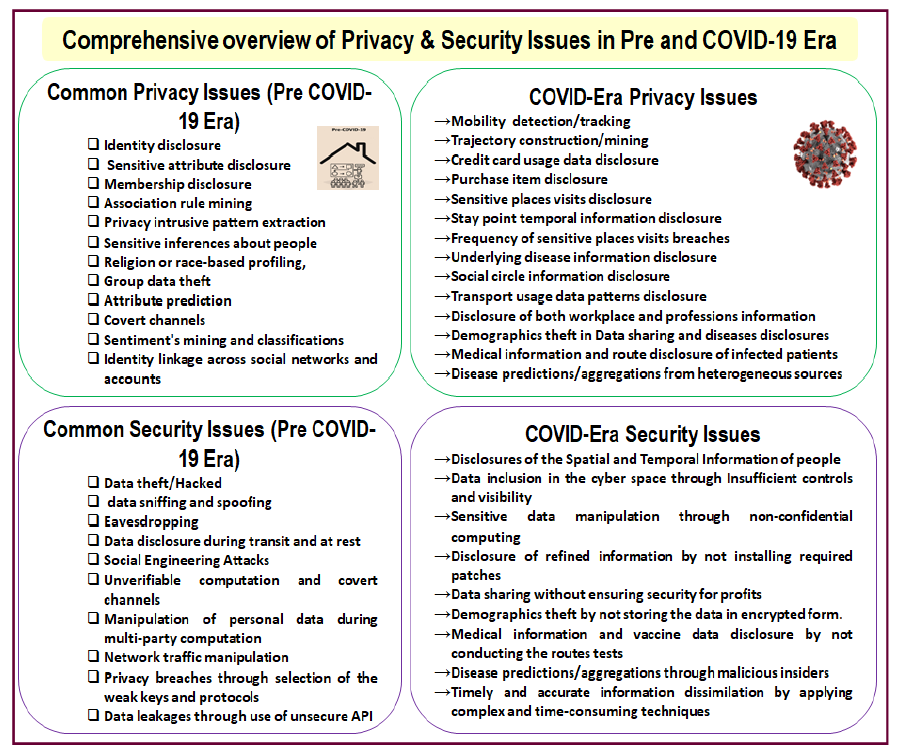
Figure 6. Comprehensive overview of the privacy and security issues prior to and in the COVID-19